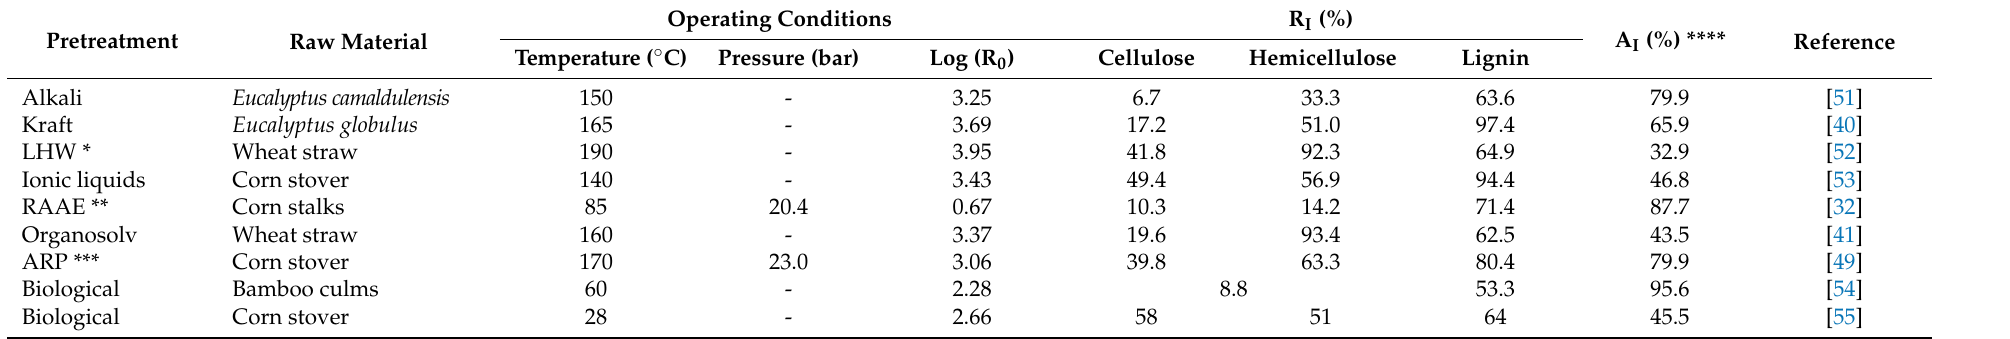
Table 3. Pretreatment screening for lignin